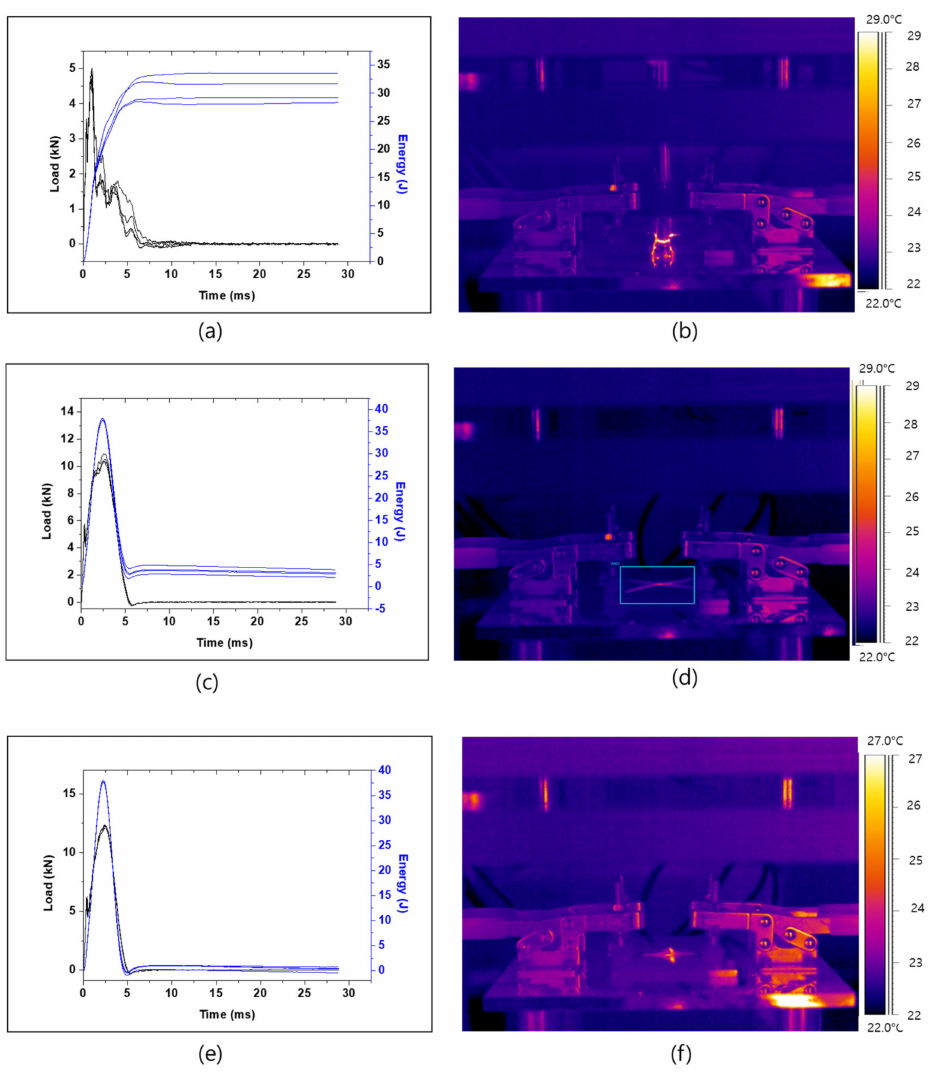
Figure 5. Impact test results for energy and load of specimens with respect to time (left), and thermal distribution image (right): ( a , b ) specimen laminated at an angle of 0 ◦ ; ( c , d ) specimen laminated at an angle of +45 ◦ / − 45 ◦ and ( e , f ) specimen laminated at an angle of 0 ◦ /90 ◦ . Table 2. Impact test results for specimens laminated in 0 ◦